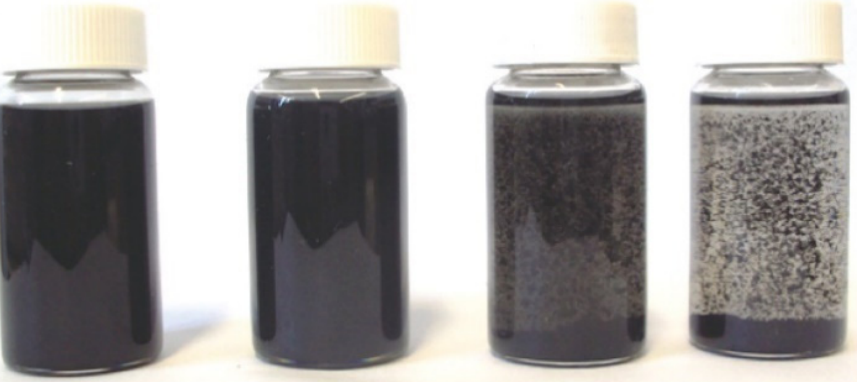
Figure 9. Photographs of various CNT dispersion in dilute epoxy solution (xylene-butanol (1:1) mixture) when the mixture was allowed to settle for 6 h. From left to right: CNT-ODA; CNT-OH; CNT-COOH and CNT-raw Copyright 2010, American Chemical Society. Reprinted with permission from Ref. [193]. Copyright 2004 American Chemical Society.